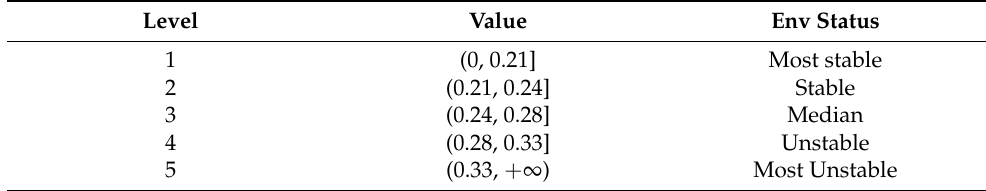
Table 2. Environment complexity